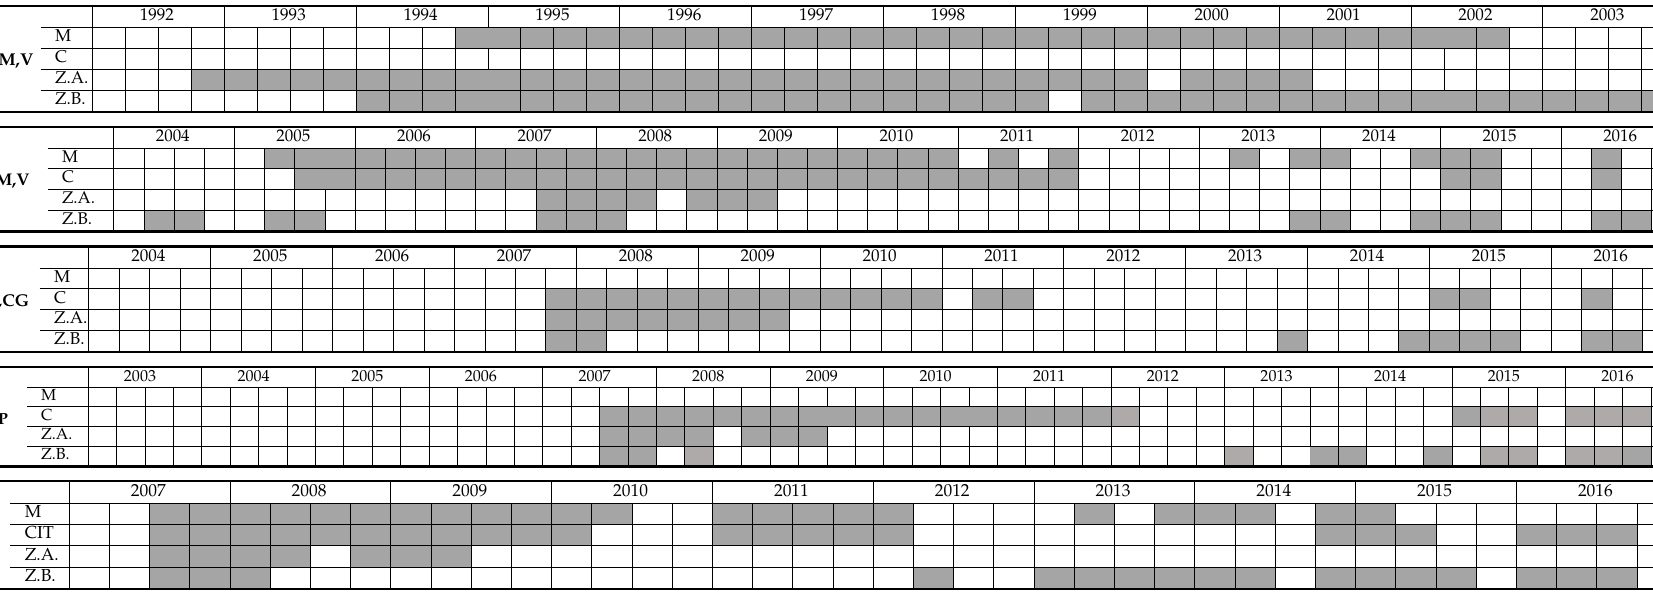
Table 1. Data available for each variable (M: micro-phytoplankton, C: pico and nanoplankton by citometry; Z.A. zooplankton abundance and Z.B. zooplankton biomass) (rows) at each transect, and year (columns). Grey color indicates data available. Every year is divided in four columns, one per season (winter, spring, summer and autumn). On the left the name/s of the transect: P (Cape Pino), M (Malaga), V(V é lez), S (Sacratif), CG (Cape Gata), CP (Cape Palos), C (Ibiza